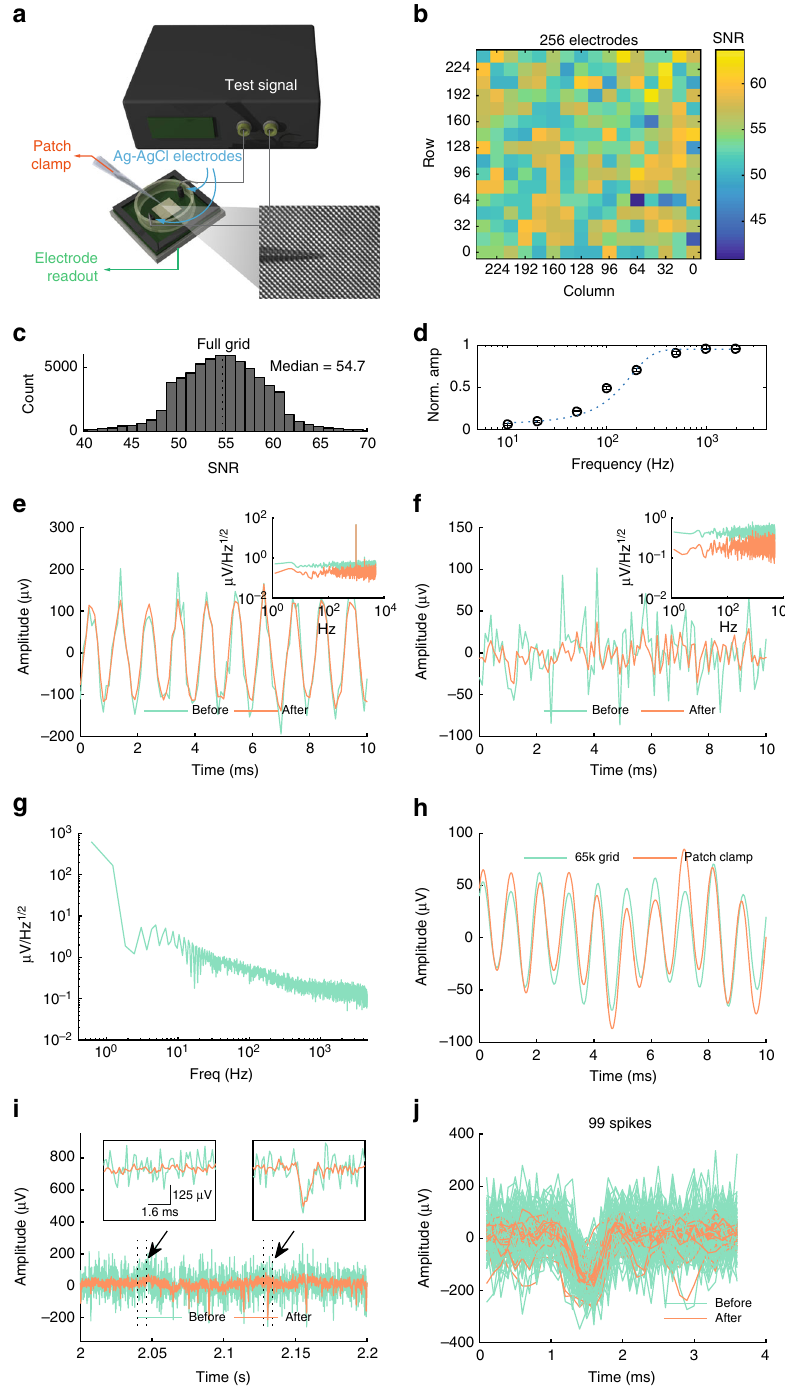
Fig. 2 System performance characterization. a Test setup. Recordings from the 65,536-channel grid are compared against patch clamp recordings. Inset photo: pipette above the grid. b SNR variation across the array, measured at every sixteenth row and column. The test signal was a bath-applied 1-kHz, 200 µ V sine wave. c SNR distribution for all electrodes in the array. d Frequency response of the capacitive recording front-end (mean ± SEM, 8 electrodes). e , f Comparison of per-channel data, before (green) and after (orange) removal of aliased thermal noise, for a recording with 1 kHz signal e and a baseline recording f . Insets in e and f : PSD plots of time-domain data in e and f , respectively. The dc component has been removed to better illustrate the linear reduction in noise fl oor across frequencies. g The system ’ s input referred noise was ~10 µ V rms over 100 – 10k Hz, in saline. h Comparison to patch clamp ampli fi er recordings. The test signal was a 1 kHz, 100 µ V peak-to-peak sine wave. Both traces have been bandpass fi ltered between 300 – 3k Hz for clarity. i Recordings before and after removing aliased thermal noise. Inset: expanded view of segment without and with spike, respectively. j Overlaid traces for 99 spike segments before and after removing aliased noise. Traces in i and j are un fi